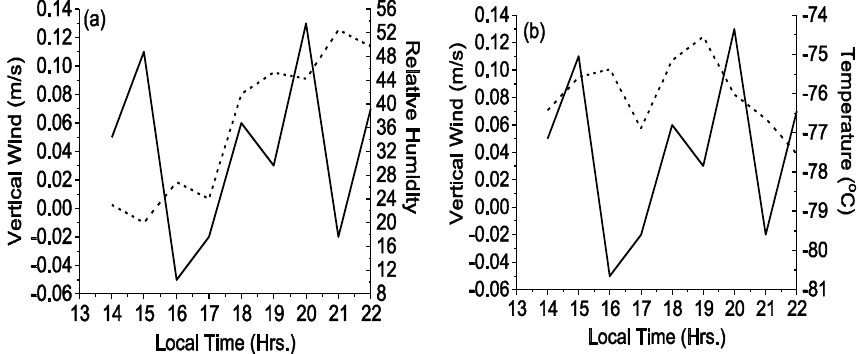
Figure 13. (a) Temporal behavior of humidity (dotted line) and vertical wind (solid line), (b) Temporal behavior of temperature (dotted line) and vertical wind (solid line) in the UTLS region (16 km height) on 30 Nov 05.